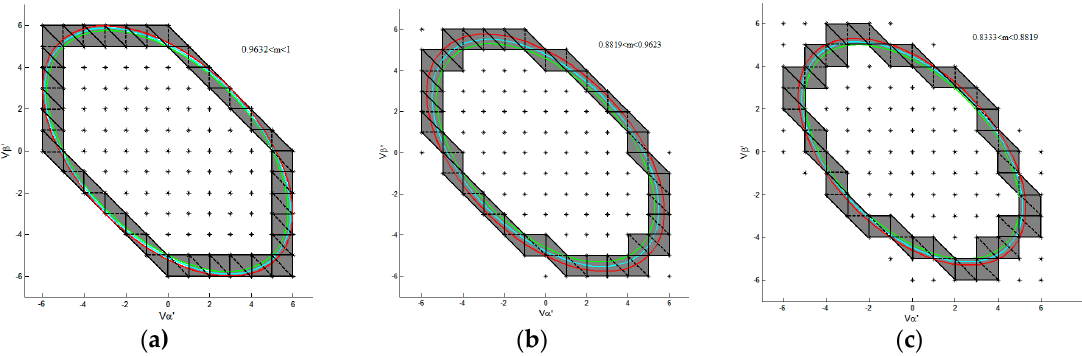
Figure 5. Traversing graphs of reference voltage vector with different modulation indexes for 7-level inverter, ( a ) 0.9632 < m < 1; ( b ) 0.8819 < m < 0.9632; ( c ) 0.8333 < m < 0.8819.